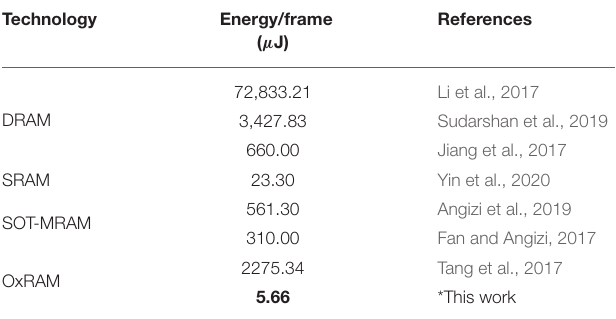
TABLE 4 | Benchmarking performance with respect to other literature studies for implementation of binarized AlexNet.